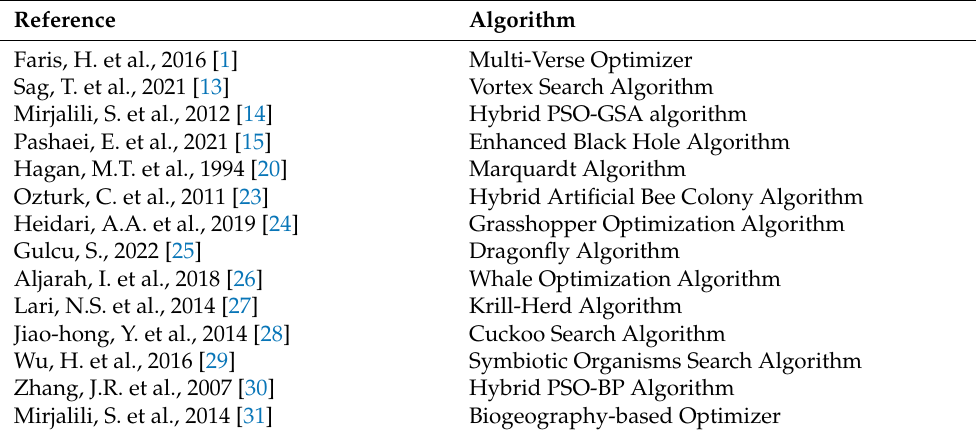
Table 1. Brief summary of algorithms used in the literature for FNN